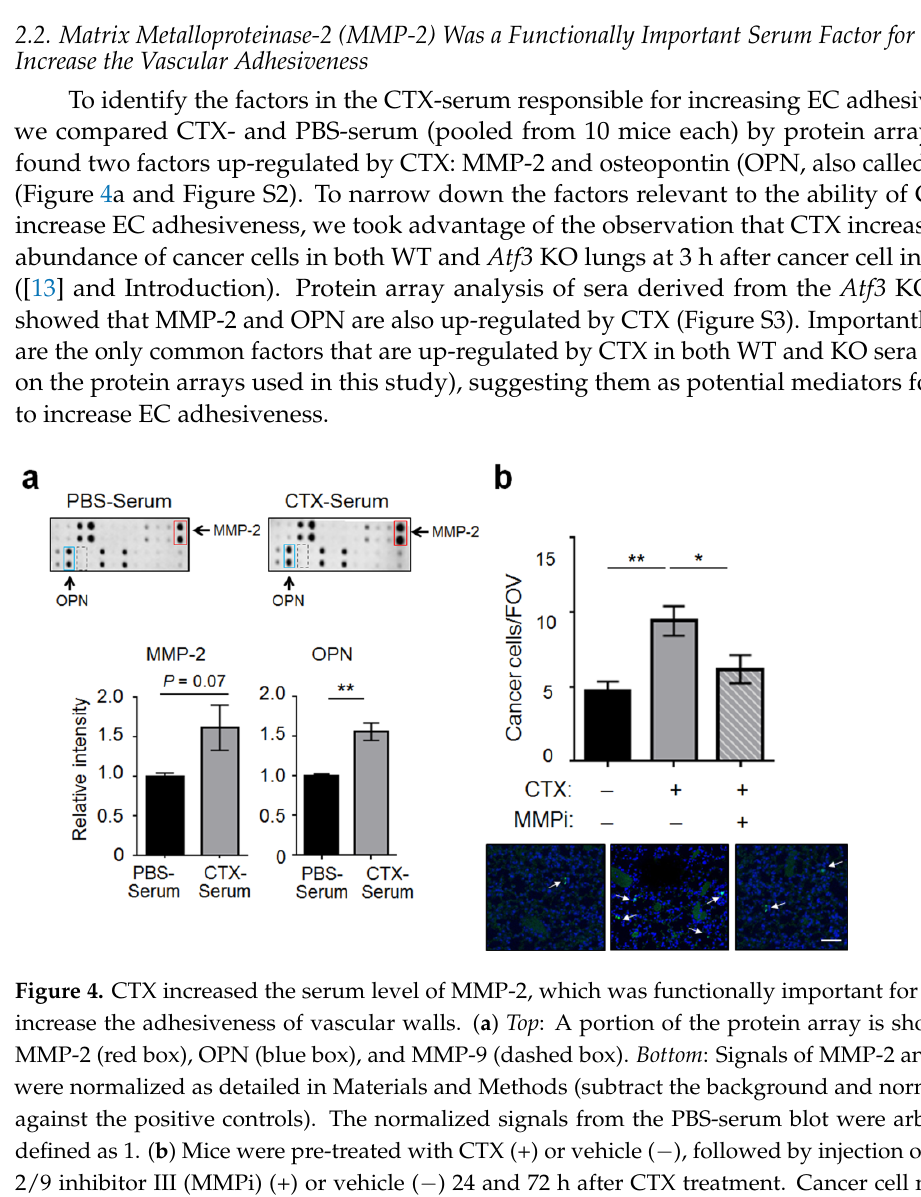
Figure 3. CTX-serum increased the mLEC adhesiveness in vitro. ( a ) A schematic. ( b ) Top : Quantifi- cation of tGFP-MVT1 cells per FOV adhered to mLECs pre-treated with CTX-serum, PBS-serum, or medium only (−) ( n = 13–14 from 3 independent experiments). Total 360 images from 3 groups were pooled, randomized and scored in blind. Bottom : Representative images. Scale bar, 100 μm. Bars indicate mean ± SEM; one-way ANOVA with post hoc Holm–Šídák correction; * p < 0.05; ** p < 0.01; *** p < 0.001.